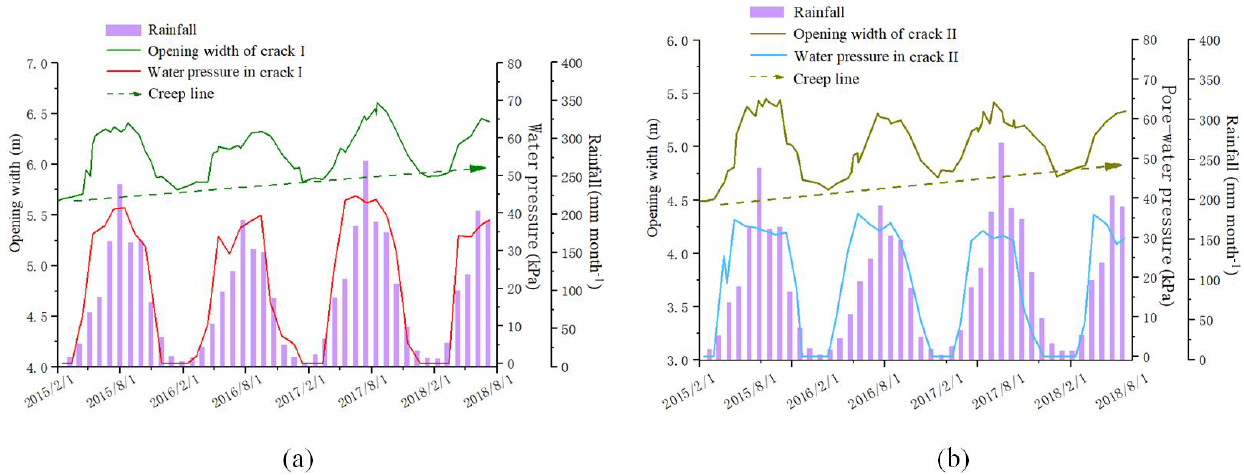
Figure 6. The monitoring data curves: (a) opening width of crack I, water pressure, and rainfall with respect to monitoring time, and (b) opening width of crack II, water pressure, and rainfall with respect to monitoring time.